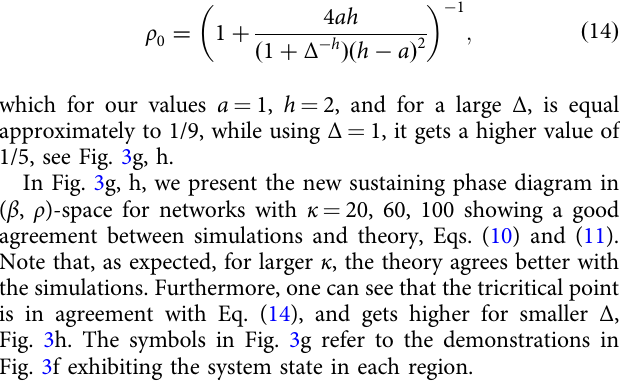
Fig. 3f exhibiting the system state in each region.